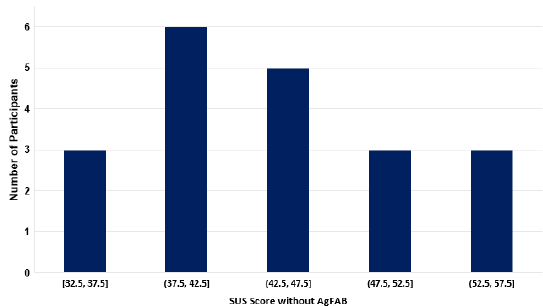
Figure 5. Histogram of SUS Score (without AgFAB)